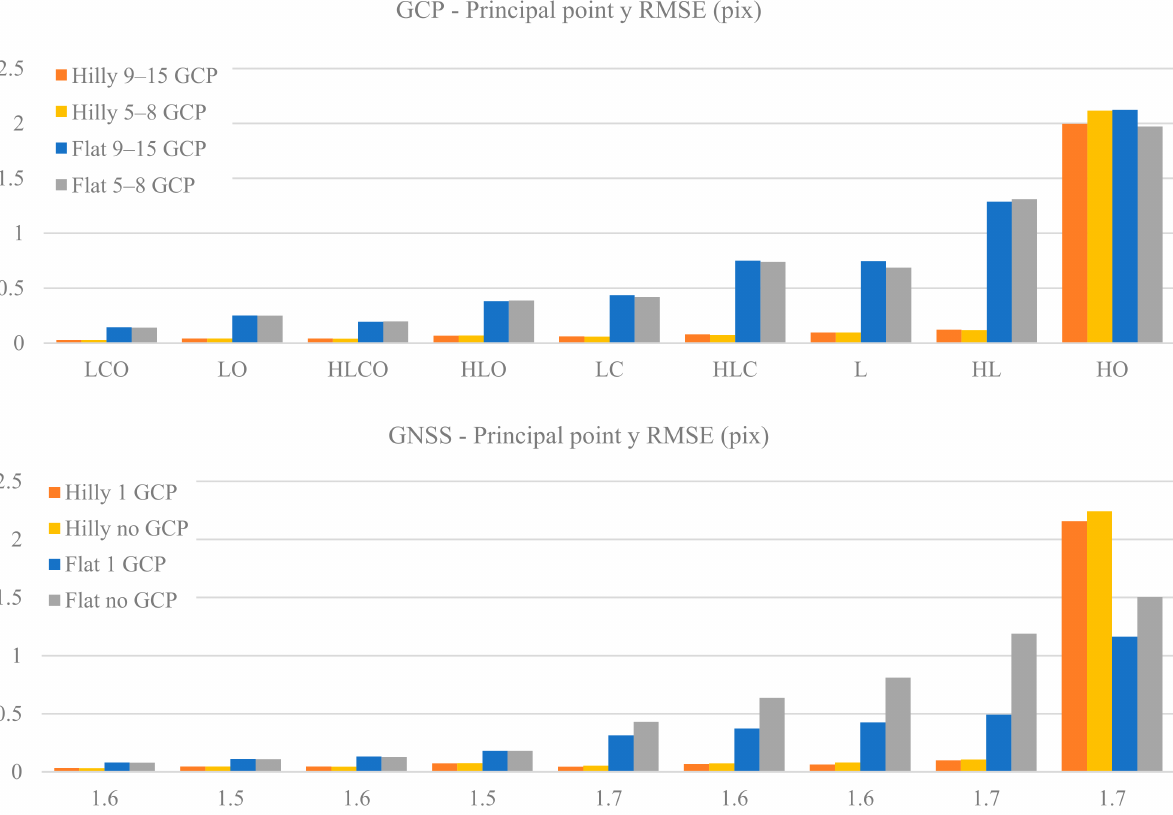
Figure 5. RMSE of the principal point y coordinate as a function of block configuration, terrain type (Flat, Hilly) and control tightness (Basic or Enhanced): ( top ): GCP case; ( bottom ): GNSS